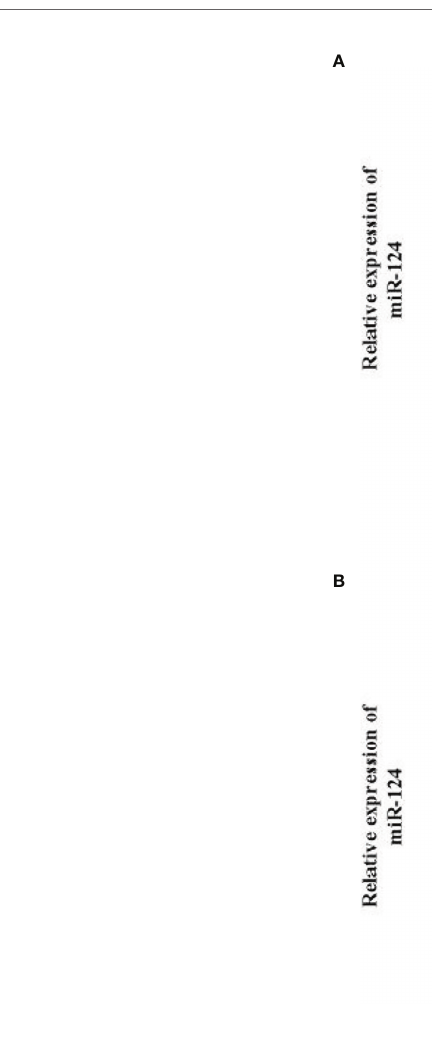
FIGURE 2 | Ef fi ciency detection of miR-124 overexpression. 100nM control mimics (A) , miR-124 mimics (A) , control inhibitors (B) , or miR-124 inhibitors (B) were transfected into the GS cells in 12 well plate. The cells at 24 h and 48 h was collected and the expression of miR-124 was detected. U6 was used as internal reference. Control mimics, miR-con; miR-124 mimics, miR-124; control inhibitors, in-con; miR-124 inhibitors, in-124. All data are presented as Mean ± SD, N = 4. Compared with the control group, signi fi cant difference of experimental group is indicated with *( P <